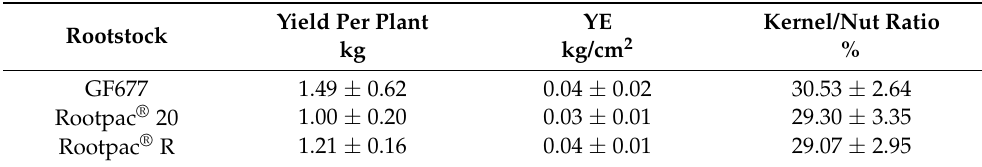
Table 7. Yield per plant, yield efficiency (YE), and kernel/nut ratio recorded for cultivar ‘Guara’ in the trial B during the growing season 2021. Data are reported as mean ± standard deviation. Different lowercase letters on the columns indicate significant differences between rootstocks (Fisher’s test p < 0.05).